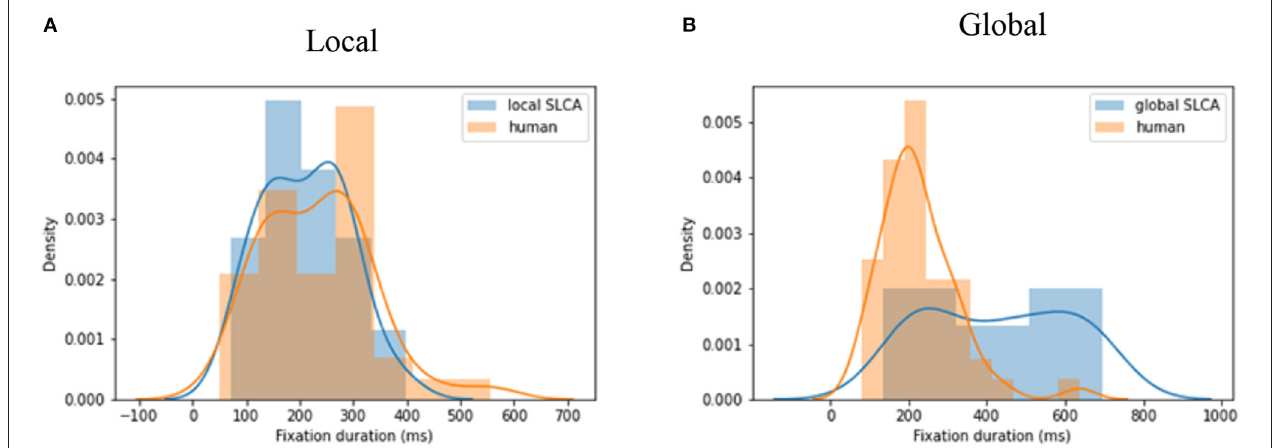
FIGURE 3 | (A) The KS-statistic is equal to 0.08 ( p < 0.05) for local SLCA; (B) the KS-statistic is equal to 0.32 ( p < 0.05) for global SLCA.